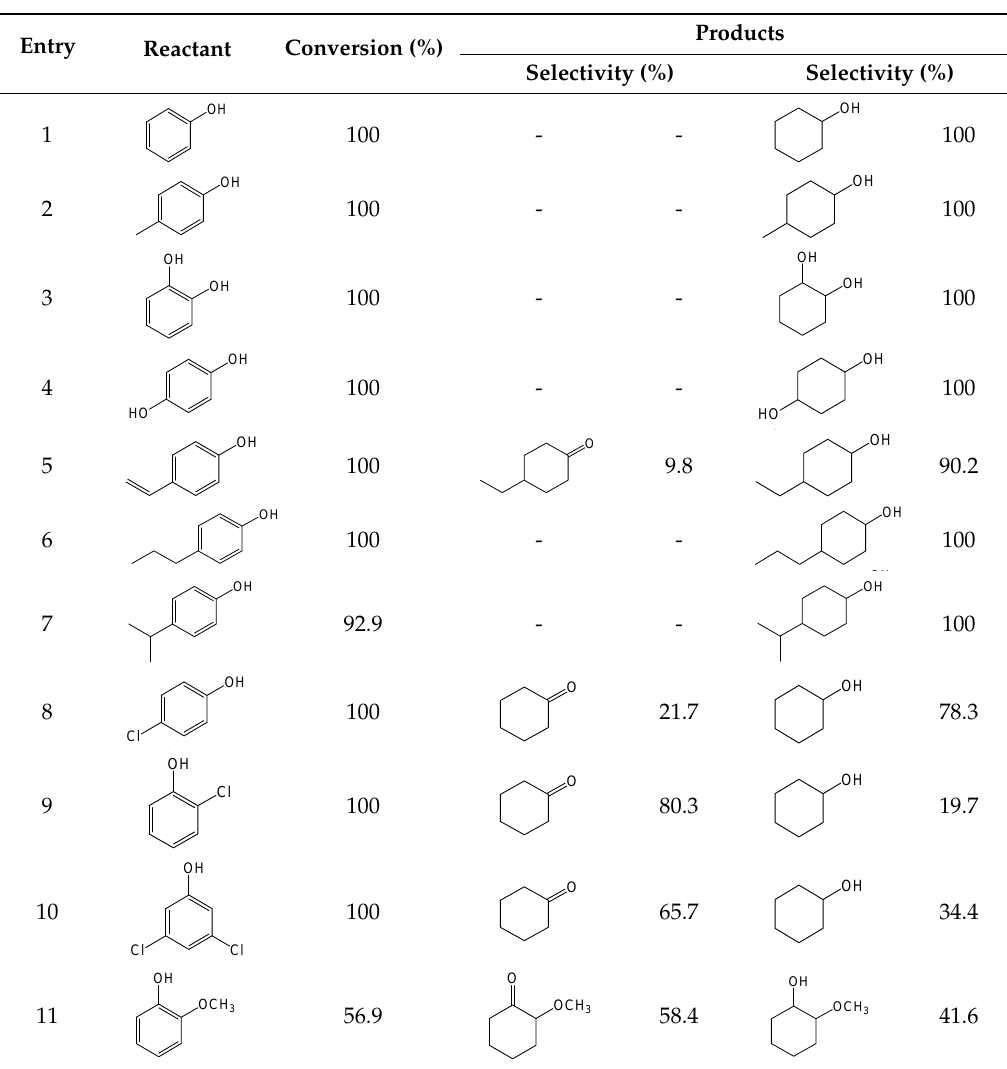
6 of 12 Figure 4. Effect of Pd loading on the hydrogenation of 4 ‐ ethylphenol. Reaction conditions: 25 mL H 2 O, 0.82 mmol 4 ‐ ethylphenol, 0.20g Pd/ γ‐ Al 2 O 3 , 2 MPa H 2 , 12 h, 60 °C. 2.3. Hydrogenation of Other Substituted Phenols The aqueous phase hydrogenation of phenols with different substituent groups was performed over a 3 wt. % Pd/ γ‐ Al 2 O 3 catalyst. Under the optimized conditions (60 °C, 2 MPa H 2 , 12 h), a range of bio ‐ derived phenols with electron ‐ donating groups such as –CH 3 , CH 3 CH 2 , –(CH 2 ) 2 CH 3 and –CH(CH 3 ) 2 were selectively hydrogenated into cyclohexanols with both high conversion of substituted phenols and high selectivity to products (see Table 3). Unexpectedly, the chosen chlorophenols exhibited full conversion under this reaction condition. The products of chlorophenol hydrogenation were cyclohexanone and cyclohexanol with different selectivities depending on both the different substituted position of –Cl and the number of –Cl. This result indicated that dechlorination occurred in the reaction process. According to the reports [35,36], it was found that the –Cl was very difficult to remove from a benzene ring of chlorophenol. Therefore, this work might provide a possible pathway to remove the –Cl of chlorophenol in the treatment of chlorophenols as pollutants [35]. However, guaiacol showed a much lower conversion, which might have been caused by one of the following. On the one hand, the methoxy group displayed electrophilic property when it was